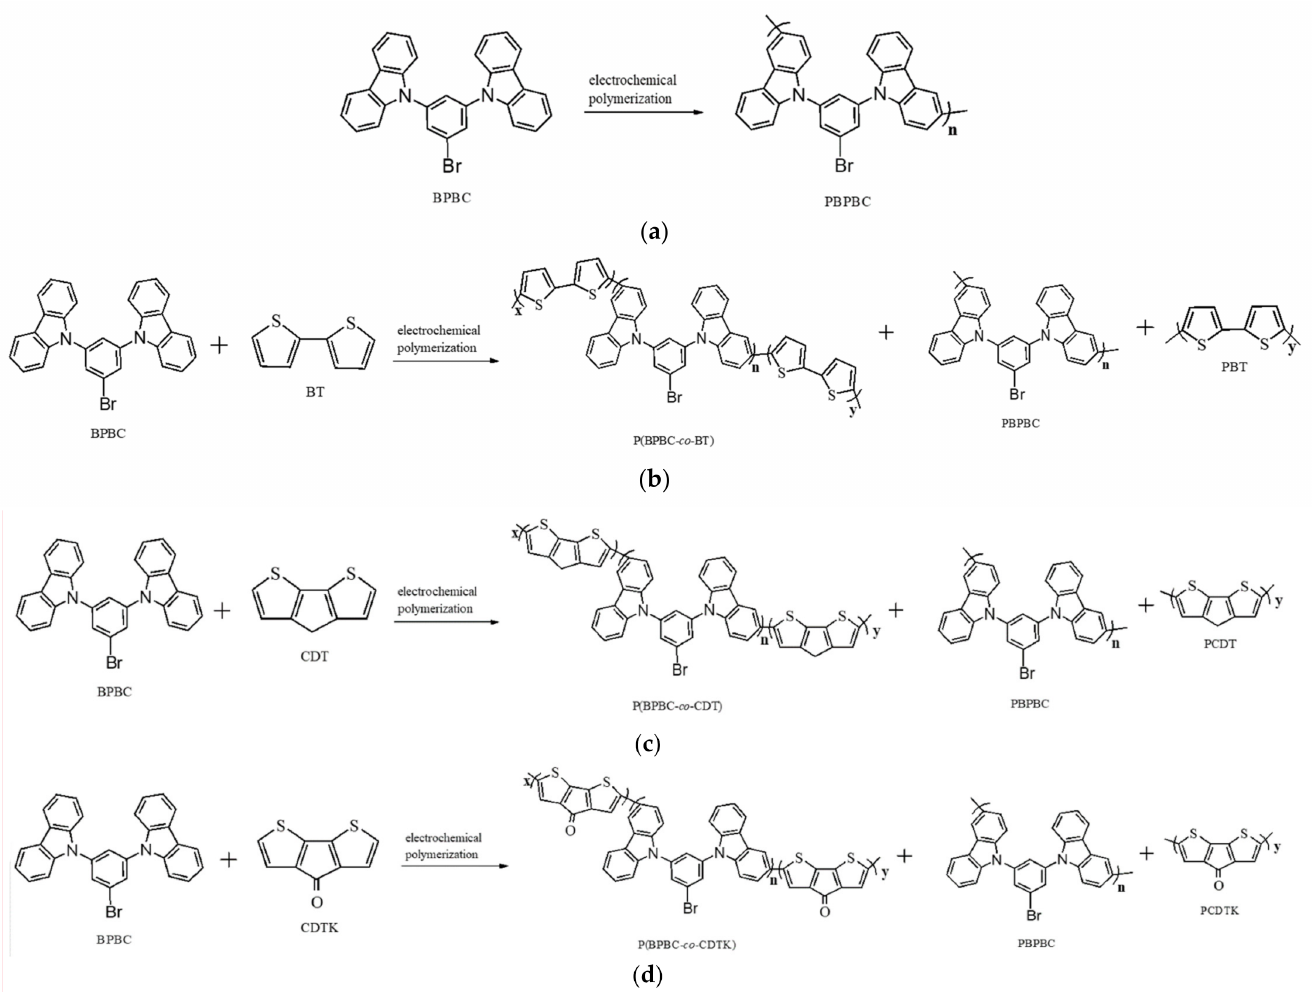
Figure 5. Electrochemical polymerizations of ( a ) PBPBC, ( b ) P(BPBC- co -BT), ( c ) P(BPBC- co -CDT), and ( d ) P(BPBC- co -CDTK). The electrochemical properties of PBPBC, P(BPBC- co -BT), P(BPBC- co -CDT), and P(BPBC- co -CDTK) films were characterized by sweeping in monomer-free electrolyte at various scan rates. Figure 6 exhibited well-defined reversible oxidization and reduction processes for PBPBC, P(BPBC- co -BT), P(BPBC- co -CDT), and P(BPBC- co -CDTK) films. The anodic and cathodic peak currents exhibited a linear growth with increasing scanning rates, disclosing that the electroactive species transferred during the oxidation-reduction reactions were nondiffusion-limited and PBPBC, P(BPBC- co -BT), P(BPBC- co -CDT), and P(BPBC- co -CDTK) were tightly attached to the ITO glasses